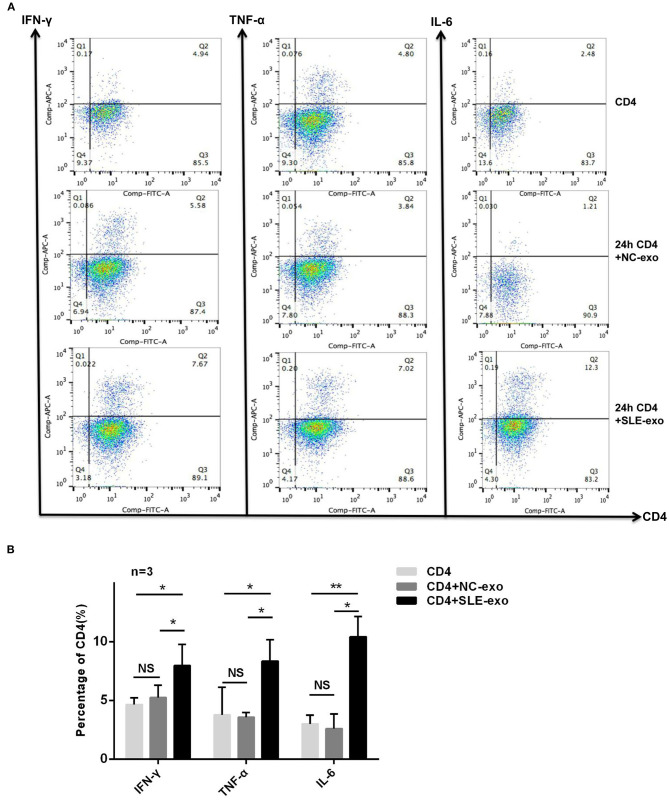
Further investigation of exosomes function by flow cytometry. (A) CD4 and anti-IFN-γ, TNF-α, or IL-6 antibody double labeling of cells was used to distinguish differential expression in CD4+ T cells before co-culture and after 24 h co-culture with exosomes of normal controls (NC) or patients with SLE in vitro. (B) Statistical analysis of the difference in expression of IFN-γ (n = 3), TNF-α (n = 3), and IL-6 (n = 3) by flow cytometry in CD4+ T cells and the results revealed the expression of IFN-γ, TNF-α, and IL-6 in CD4+ T cells co-cultured with exosomes of SLE was significantly higher than CD4+ T cells before co-culture or CD4+ T cells co-cultured with exosomes of NC, while the CD4+ T cells co-cultured with exosomes of SLE group and CD4+ T cells co-cultured with exosomes of NC group showed no differences. *P < 0.05, **P < 0.01, NS, no significance.